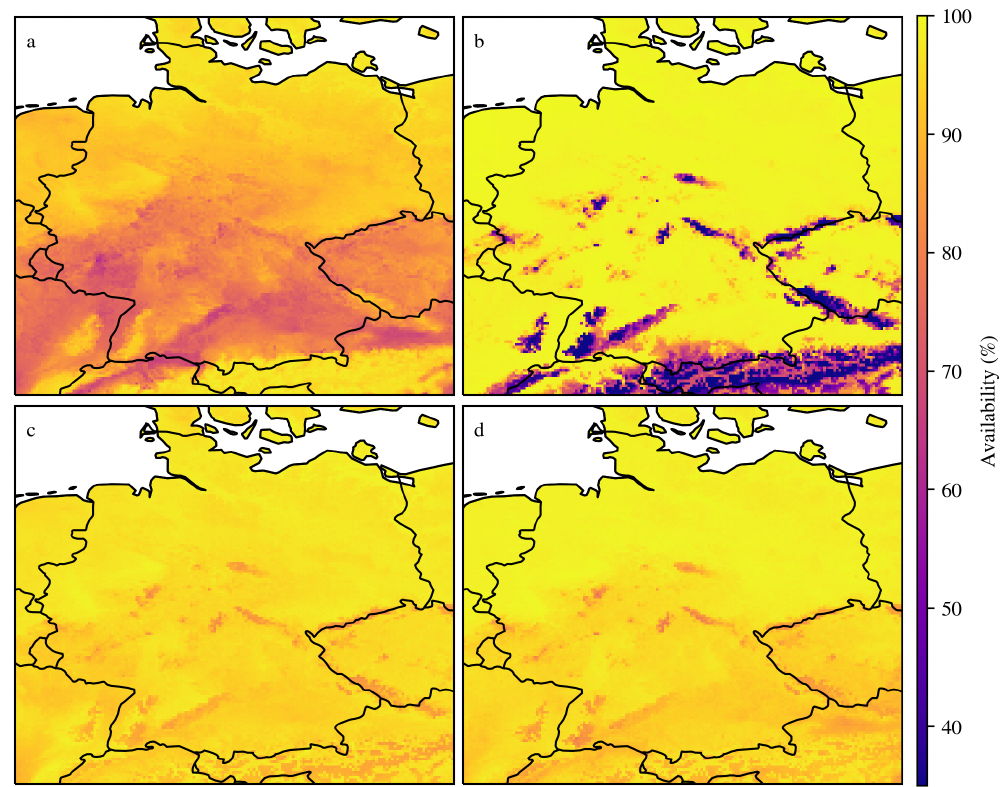
Figure 10. Example maps of availabilities based on fog patterns 8 (P8) ( a ) and 13 (P13) ( b ) from the work in [24] and GWShigh over central Europe (HM) ( c ), anticyclonic southwesterly (SWA) ( d ) from the work in [27], and assumed 10-min availability threshold of 80% at measurement heights of 130m and above.